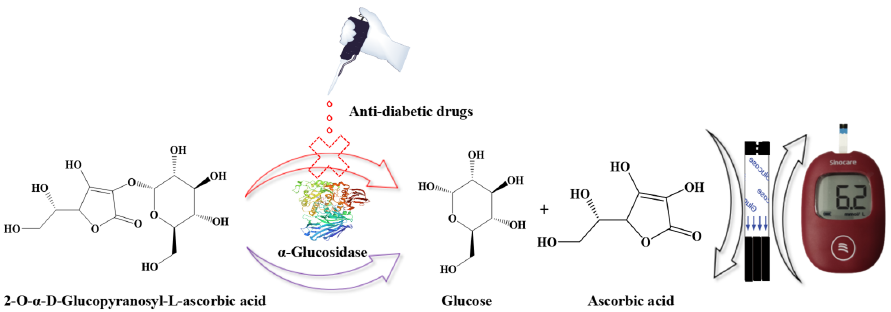
Figure 1. Schematic illustration of the principle of the PGM method based on α-glucosidase-mediated reaction.